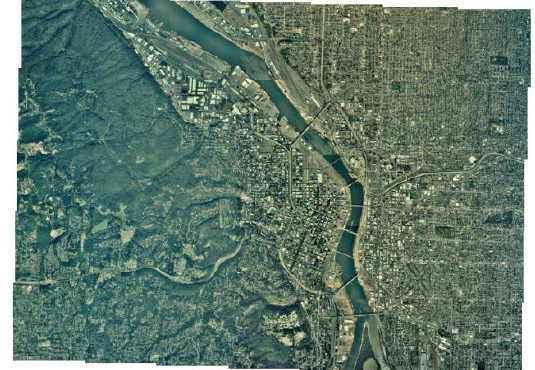
Fig.3.4 Color balance result: 3 rd Order Polynomial Target Model.